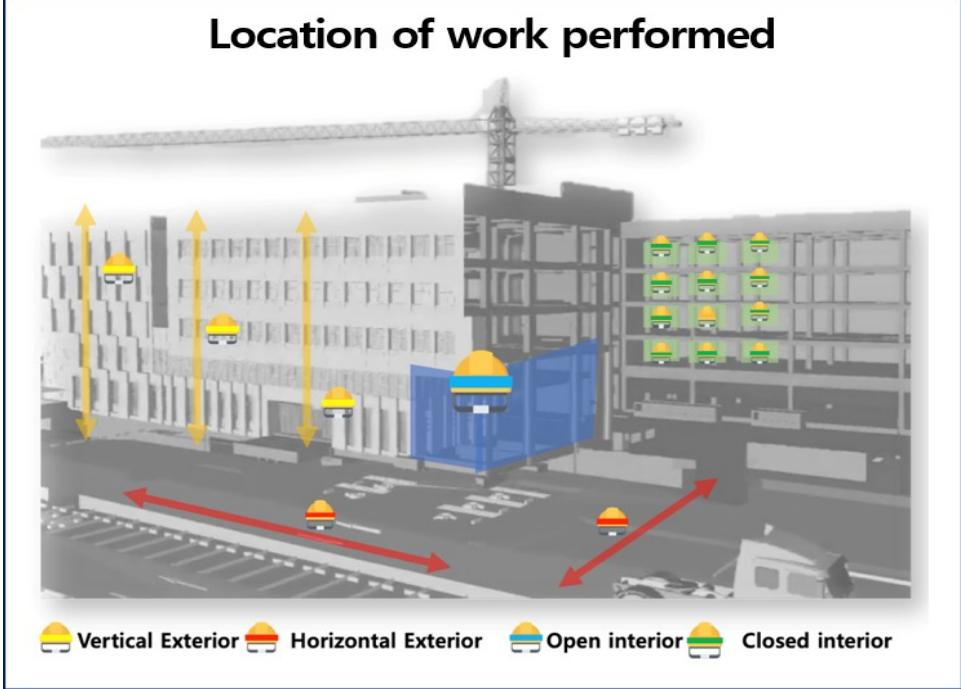
Figure 2. Different locations of work performed for acoustic analysis.